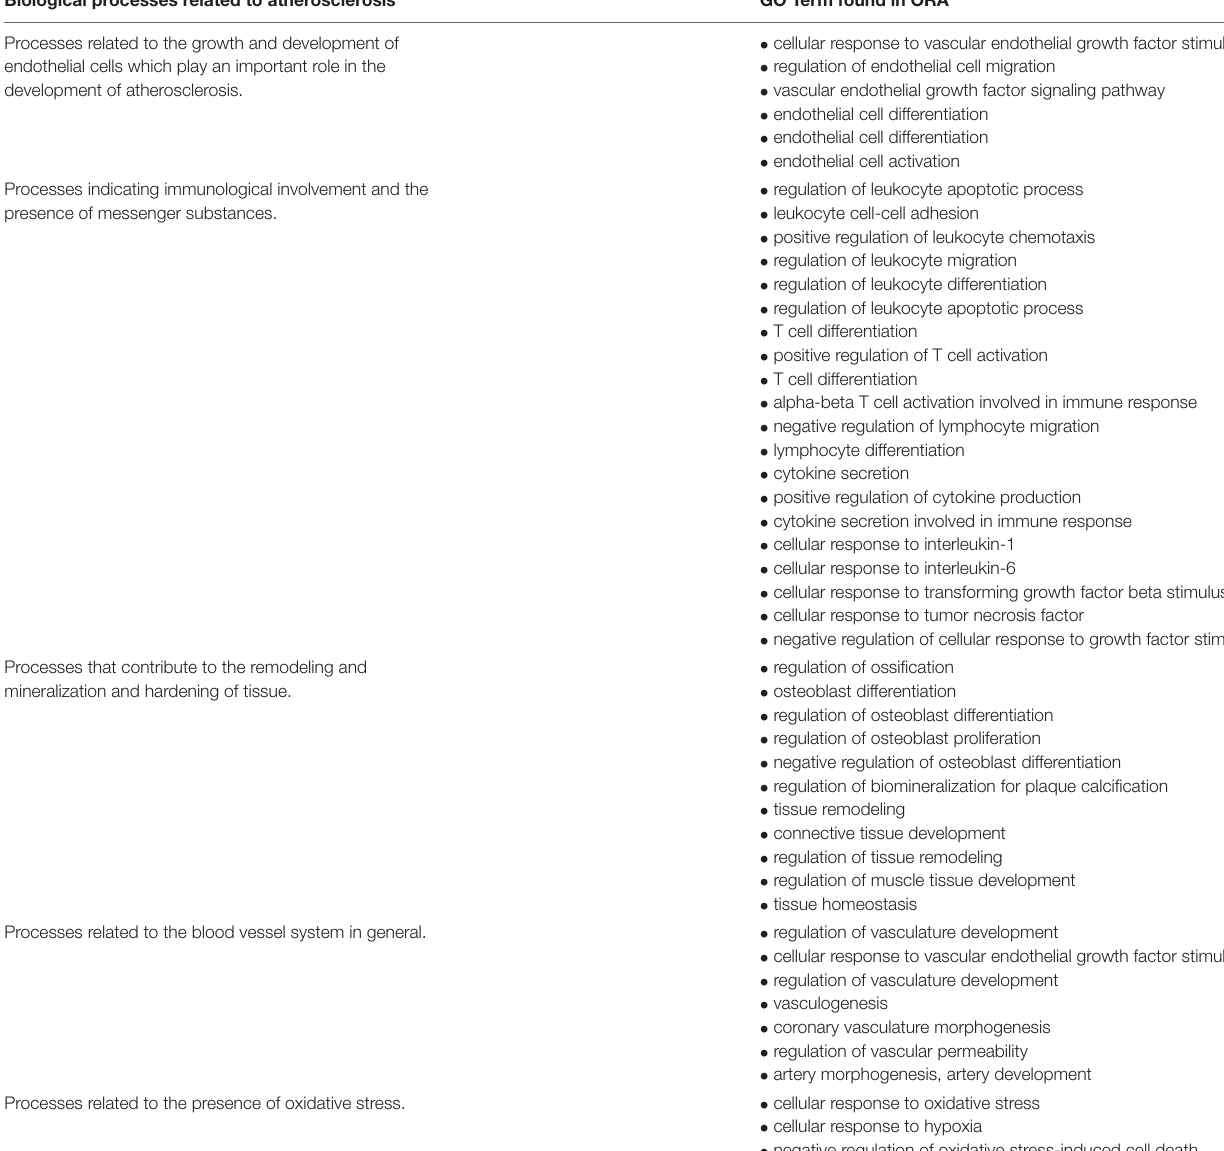
TABLE 7 | Biological processes that can be associated with atherosclerosis and the associated gene ontology (GO) terms of the overrepresentation analysis (ORA). Biological processes related to atherosclerosis GO Term found in ORA Processes related to the growth and development of endothelial cells which play an important role in the development of